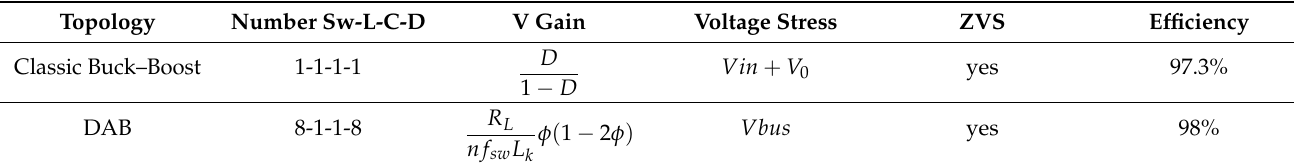
Table 7. DC-DC converters feature